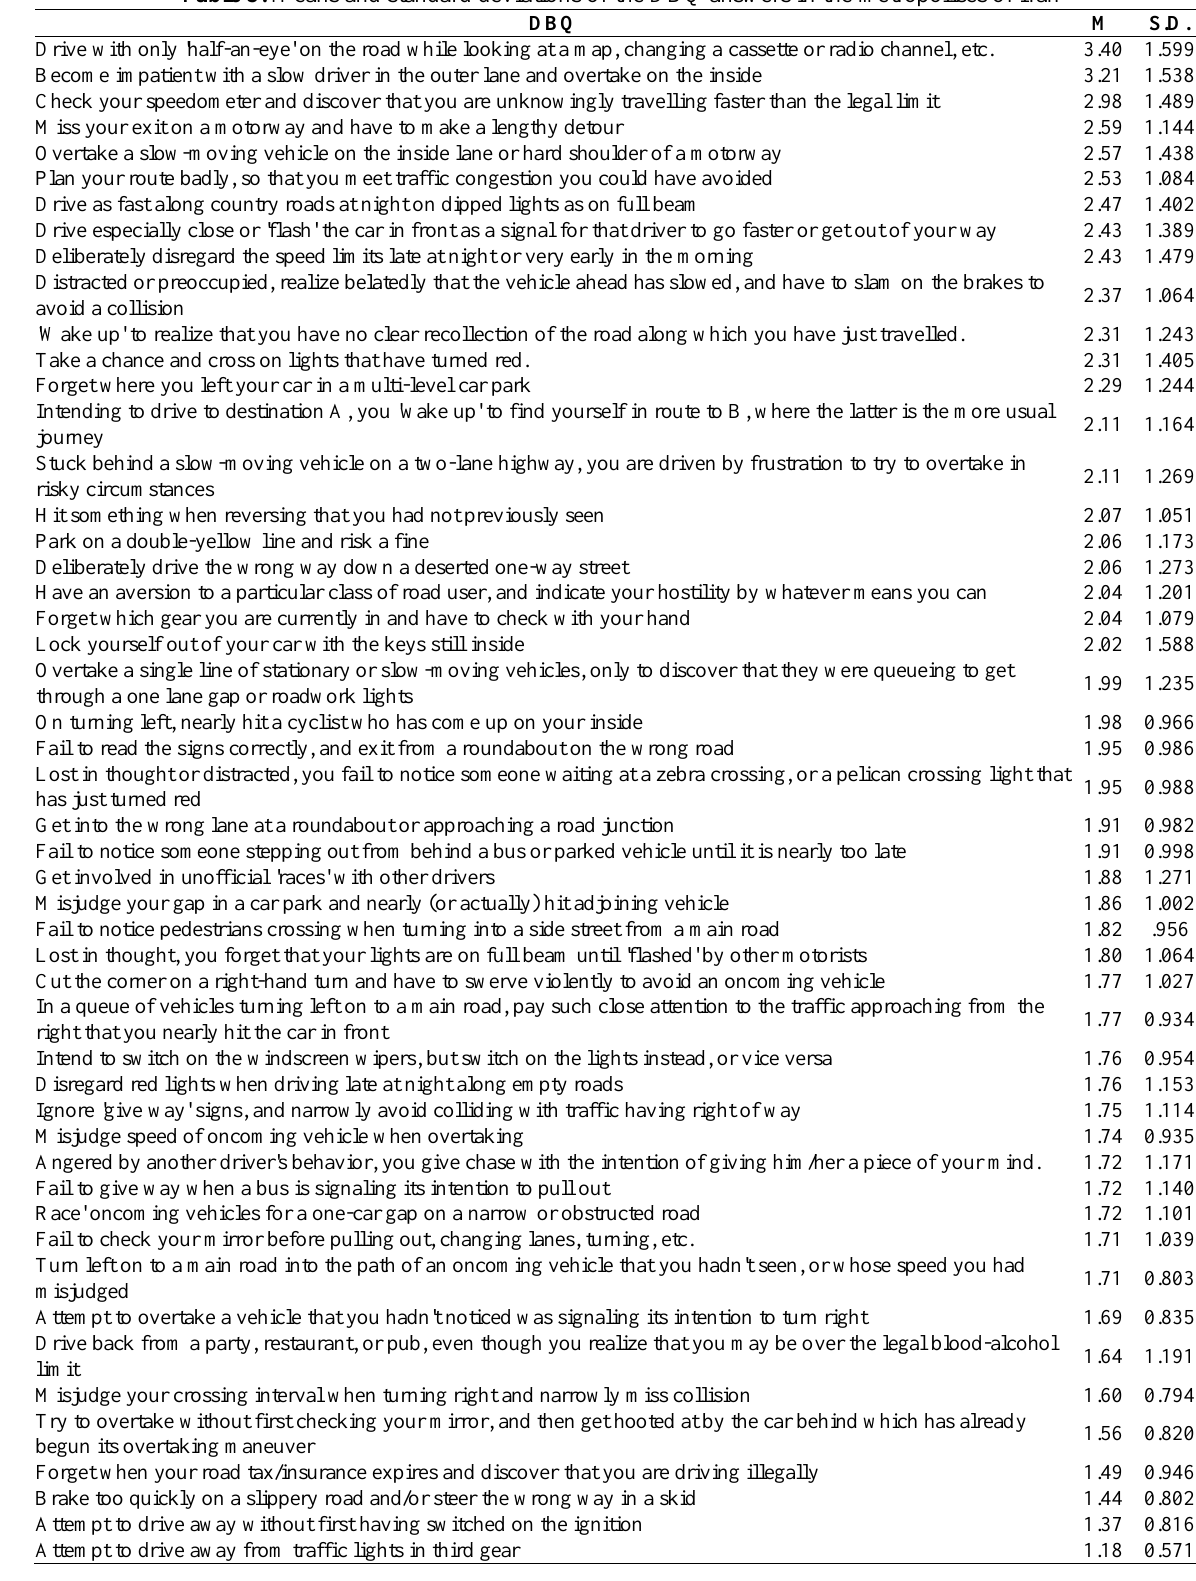
Table 3. Means and standard deviations of the DBQ answers in the metropolises of Iran DBQ M S.D.